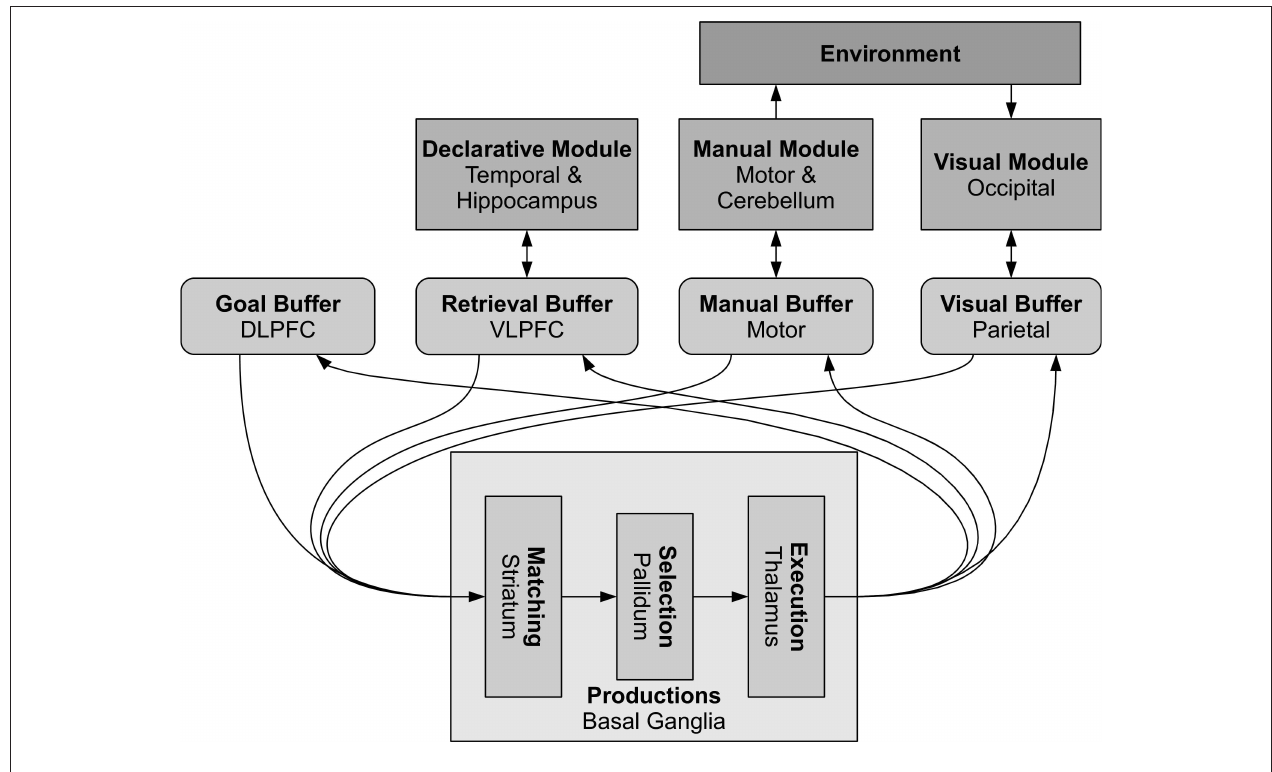
FIGURE 5 | The basic modules of ACT-R and their corresponding brain regions. The buffers are small-capacity working memories and represent the current cognitive state. The basal ganglia match this state against learned